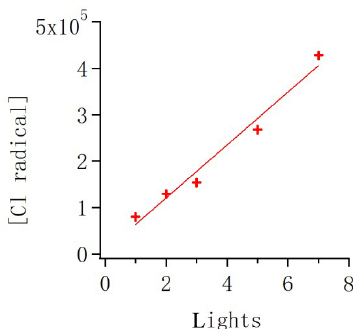
Figure 3. The variation in chlorine radical concentration as a func- tion of lights. The input alpha-pinene concentration was kept con- stant throughout the